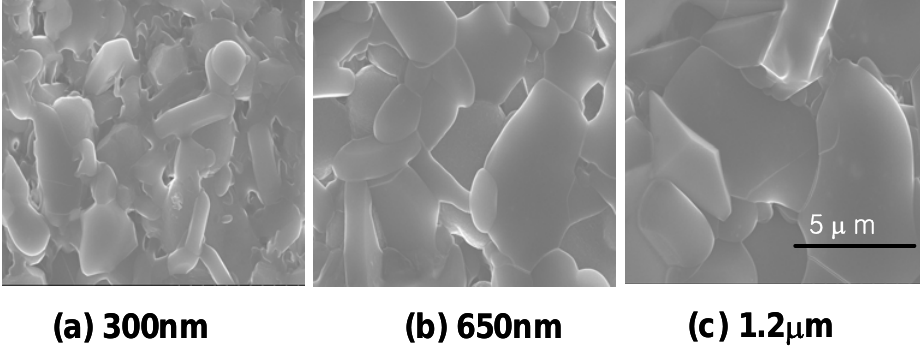
PO electrolyte thin films with thickness 3 4